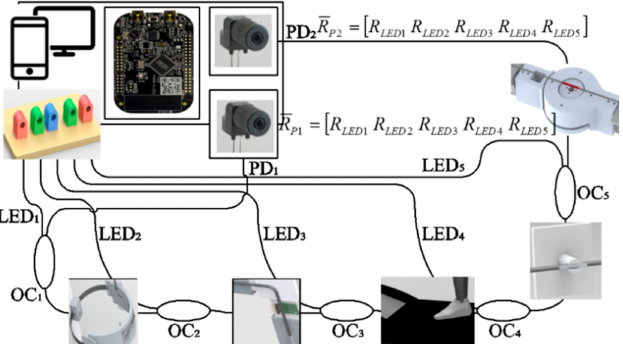
Figure 2. Experimental setup for the POF sensor integration in Scenarios 1 and 2 using the proposed multiplexing